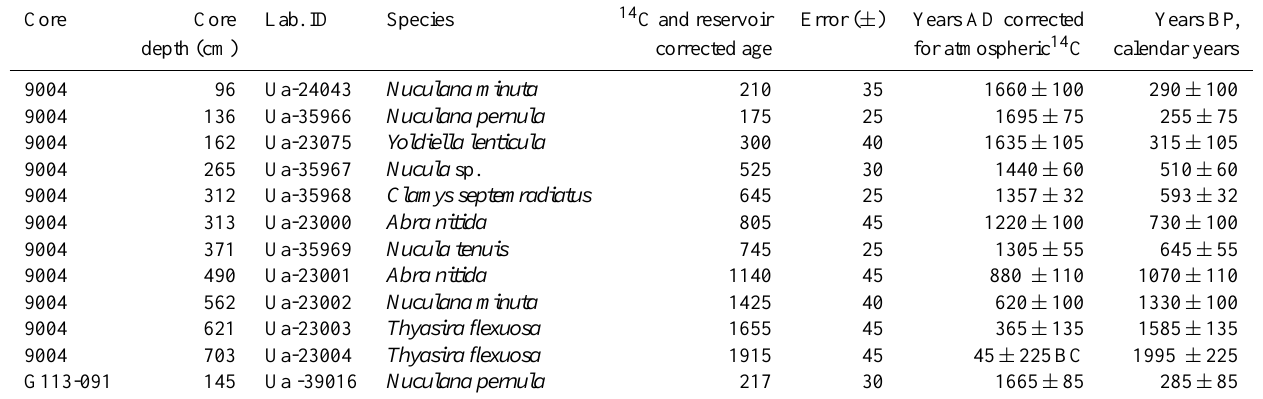
Table 1. Radiocarbon dating results based on 12 double mollusc shells recovered intact from the cores 9004 and G113-091. The correction of 14 C ages for reservoir age is modified after Filipsson and Nordberg (2010) and a 500yr reservoir age has been used based on a complementary mollusc shell dating (Nordberg and Possnert, unpublished data; Polovodova et al., 2011). The genuine depths of core 9004 in the second column were corrected for + 60cm in order to include the core GA113-2Aa on top of the record. Core Lab.